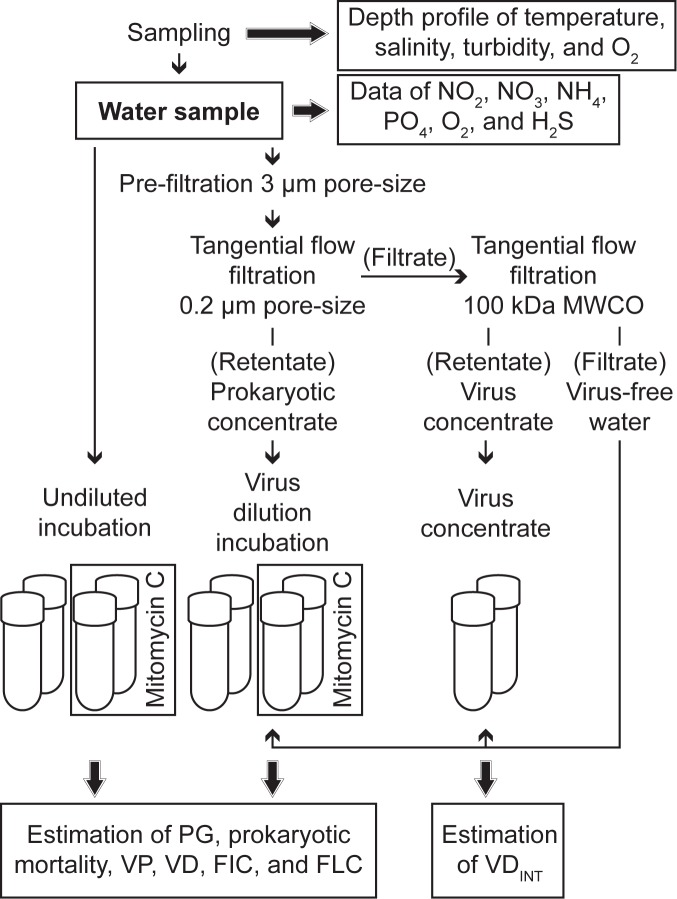
Experimental setup.The figure shows the experimental setup of undiluted and virus dilution incubations to determine rates of prokaryotic growth (PG), prokaryotic mortality, virus production (VP), viral decay (VD), and the frequency of lytically (FIC) and lysogenically infected prokaryotic cells (FLC). In parallel, intrinsic viral decay (VDINT) was estimated by incubating virus concentrate in virus-free water.